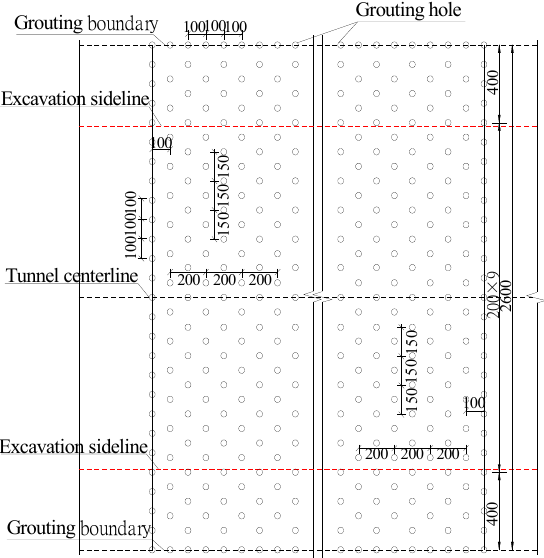
Figure 5. Plane layout of grouting holes (unit: